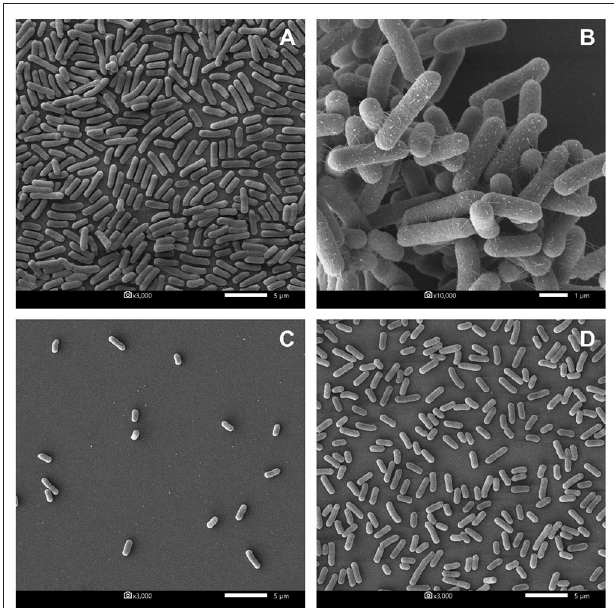
FIGURE 4 | Scanning electron micrographs of biofilm formed by E. coli P01 in planktonic stage with different conditions. (A,B) Represent E. coli grew toward Sterile MRS broth (magnification: 3000X and 10,000X, respectively). (C,D) represent E. coli cultured in non-neutralizing and neutralizing CFS of P72N, respectively (magnification: 3000X). Scale bars are 1 or 5 µ m.